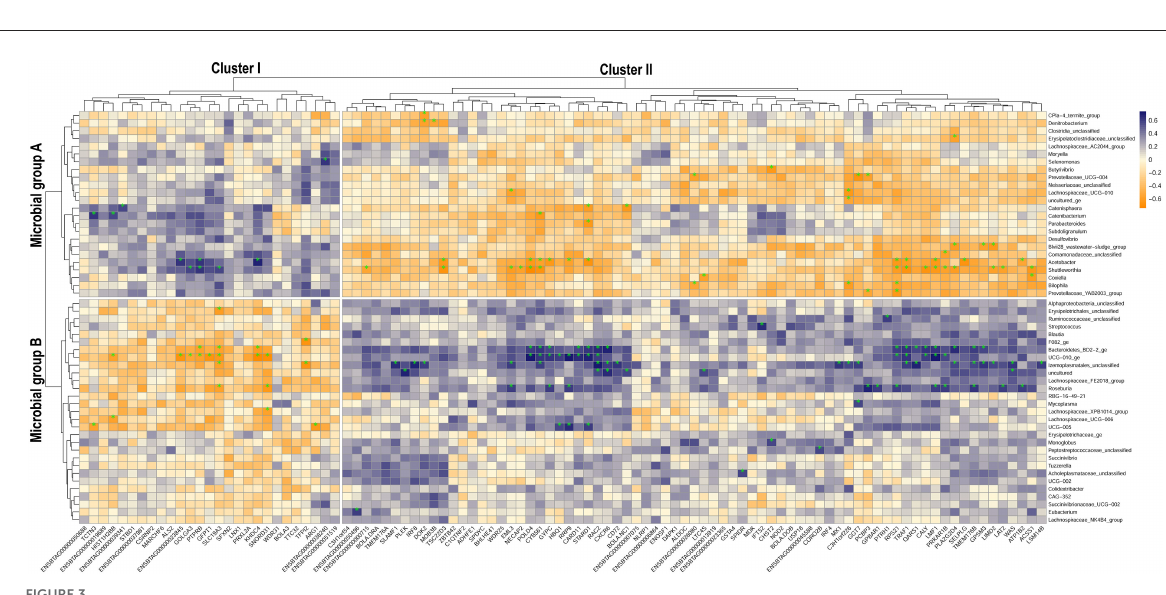
correlations with abundances of Roseburia ( r = 0.53,